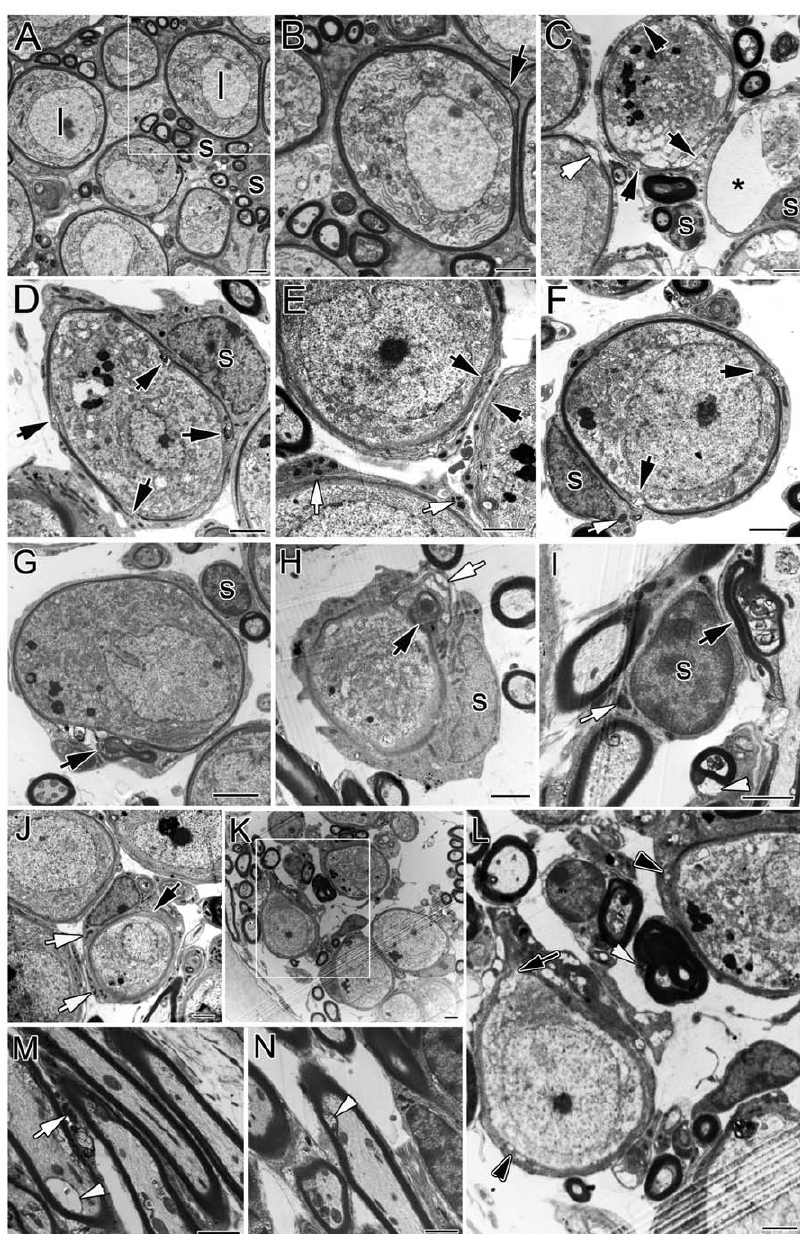
Figure 2. Age-related ultrastructural changes in CBA/CaJ mouse spiral ganglion. A, B: Normal type I (I) SGNs and myelinating Schwann cells (S) in the middle turn of a young adult mouse. B shows a higher magnification view of the boxed area in A. Chromatin is evenly distributed in the prominent nucleus and the neuronal perikaryon is surrounded by a myelin sheath and by the peripheral process of a Schwann cell. The majority of myelin sheaths enclosing type I SGNs are tightly laminated with no discontinuities. Although a separation of myelin sheath layers enveloping SGNs was occasionally seen in young adult mice (arrow), no discontinuities in the myelin sheath were seen in the young mice. C: A section from the basal turn of a 27-month-old mouse showing SGNs in various stage of degeneration. A degenerating SGN surrounded by a thinned and broken myelin sheath (black arrows) and numerous electron dense inclusions are present in the cytoplasm. On the left, a gap (white arrow) is present in the myelin sheath enclosing a relatively healthy appearing SGN. On the right, debris from a dead SGN is enclosed by a myelin sheath and a Schwann cell process (asterisk). D, E, F: Abnormalities of the myelin sheath in the middle turn of another 27-month-old mouse. Black arrows indicate areas of broken ( D, F ) and loose ( E ) myelin lamellae enclosing both degenerative and normal SGNs. The dense inclusions in the cytoplasm of Schwann cells are indicated by white arrows ( E ). G, H, I: Degenerative changes in the middle turn of a 27-month-old mouse. Abnormal partially collapsed or folded myelin sheaths (black arrows) and balloon-like features (white arrowhead) are seen surrounding the perikarya of SGNs ( G , H ) and their processes ( I ). J: Numerous electron dense inclusions in the cytoplasm of a Schwann cell in the center (white arrows). The Schwann cell associated SGN is surrounded by a broken myelin sheath (black arrow). K, L, M, N: Abnormal collapsed and folded myelin sheaths (white arrow), broken myelin sheaths (black arrow), balloon- like features (white arrowhead), and vacuole-like spaces (black arrowheads) surrounding the perikarya of SGNs ( J,L ) and auditory nerve processes within RC ( L ) and OSL ( M,N ). L is a higher magnification view of the boxed area in K . A white arrow in M points electron dense inclusions in the cytoplasm of a Schwann cell. All images in J–N were taken from a 28-month-old mouse. Scale bars=2 m m in A–N .